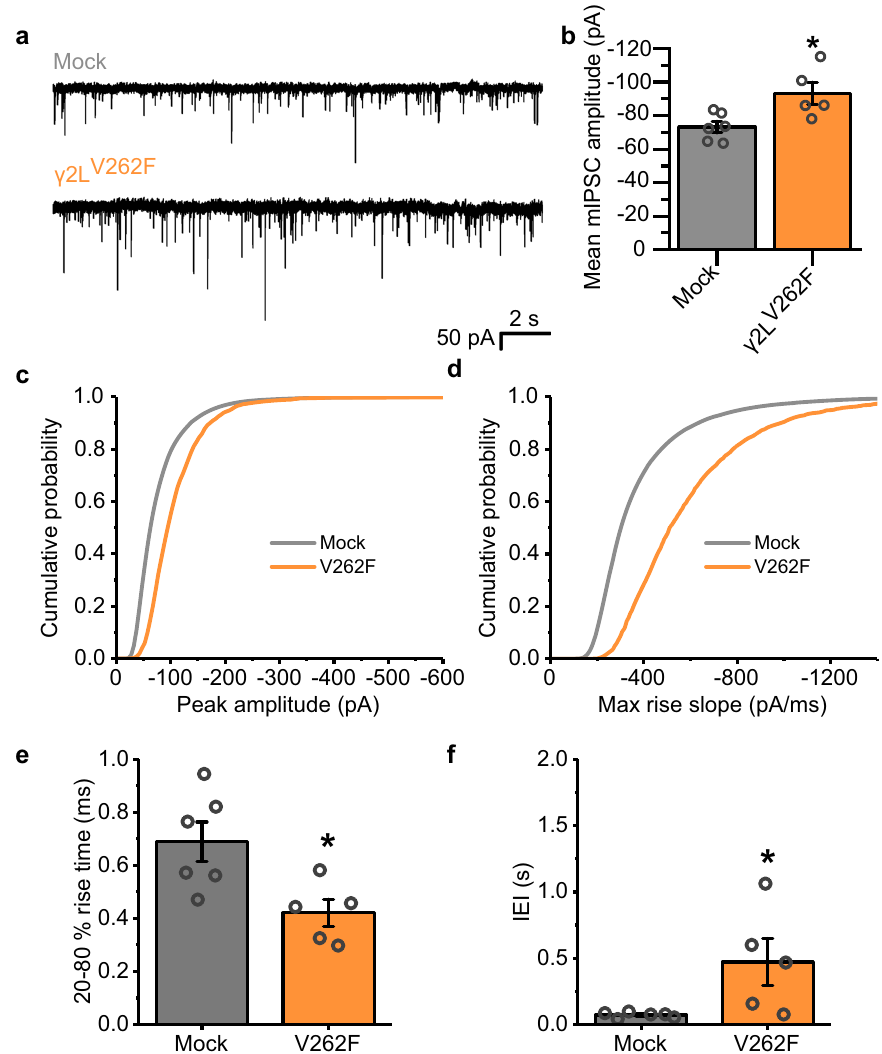
Fig. 4 γ 2 V262F expression increases miniature IPSC amplitudes. a Representative mIPSCs recorded in voltage-clamp mode from neurons in the presence of tetrodotoxin (500 nM) either mock-transfected (black) or expressing γ 2 V262F (orange). b Mean amplitudes of mIPSCs for the constructs shown in a (two-tailed t -test vs mock: t (9) = − 2.87, p = 0.019). c Cumulative probability distribution of mIPSC amplitudes and d maximum rate of rise slopes of all mIPSCs recorded; n = 18,668 events from 6 cells (mock), and 3742 events from 5 cells ( γ 2L V262F ). e Mean 20 – 80% rise times of the mIPSCs recorded from each cell (two-tailed t -test: t (9) = 2.84, p = 0.019). f Median IEI for the mIPSCs recorded from each cell (two-tailed t -test: t (9) = − 2.52, p = 0.033). Source data are provided as a Source data fi le for Fig.